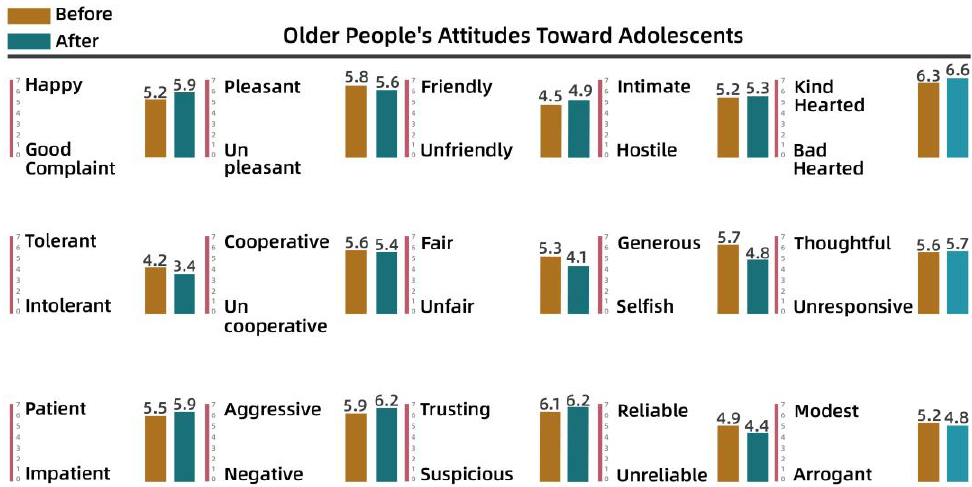
Figure 12. Older people’s attitudes toward adolescents.